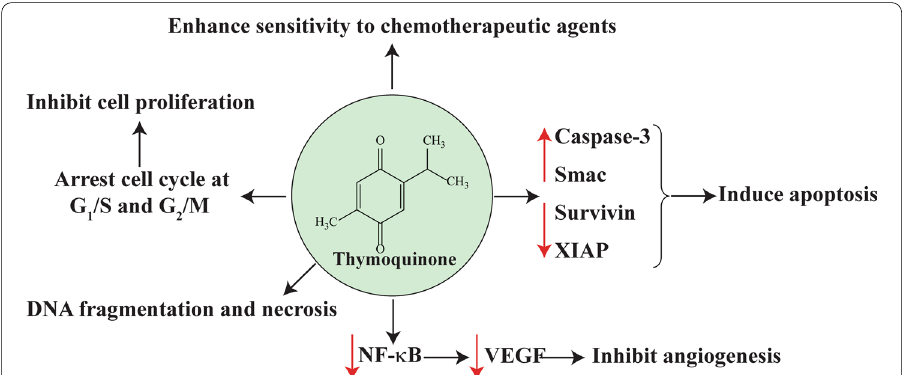
Fig. 2 The role of thymoquinone in inhibition of osteosarcoma